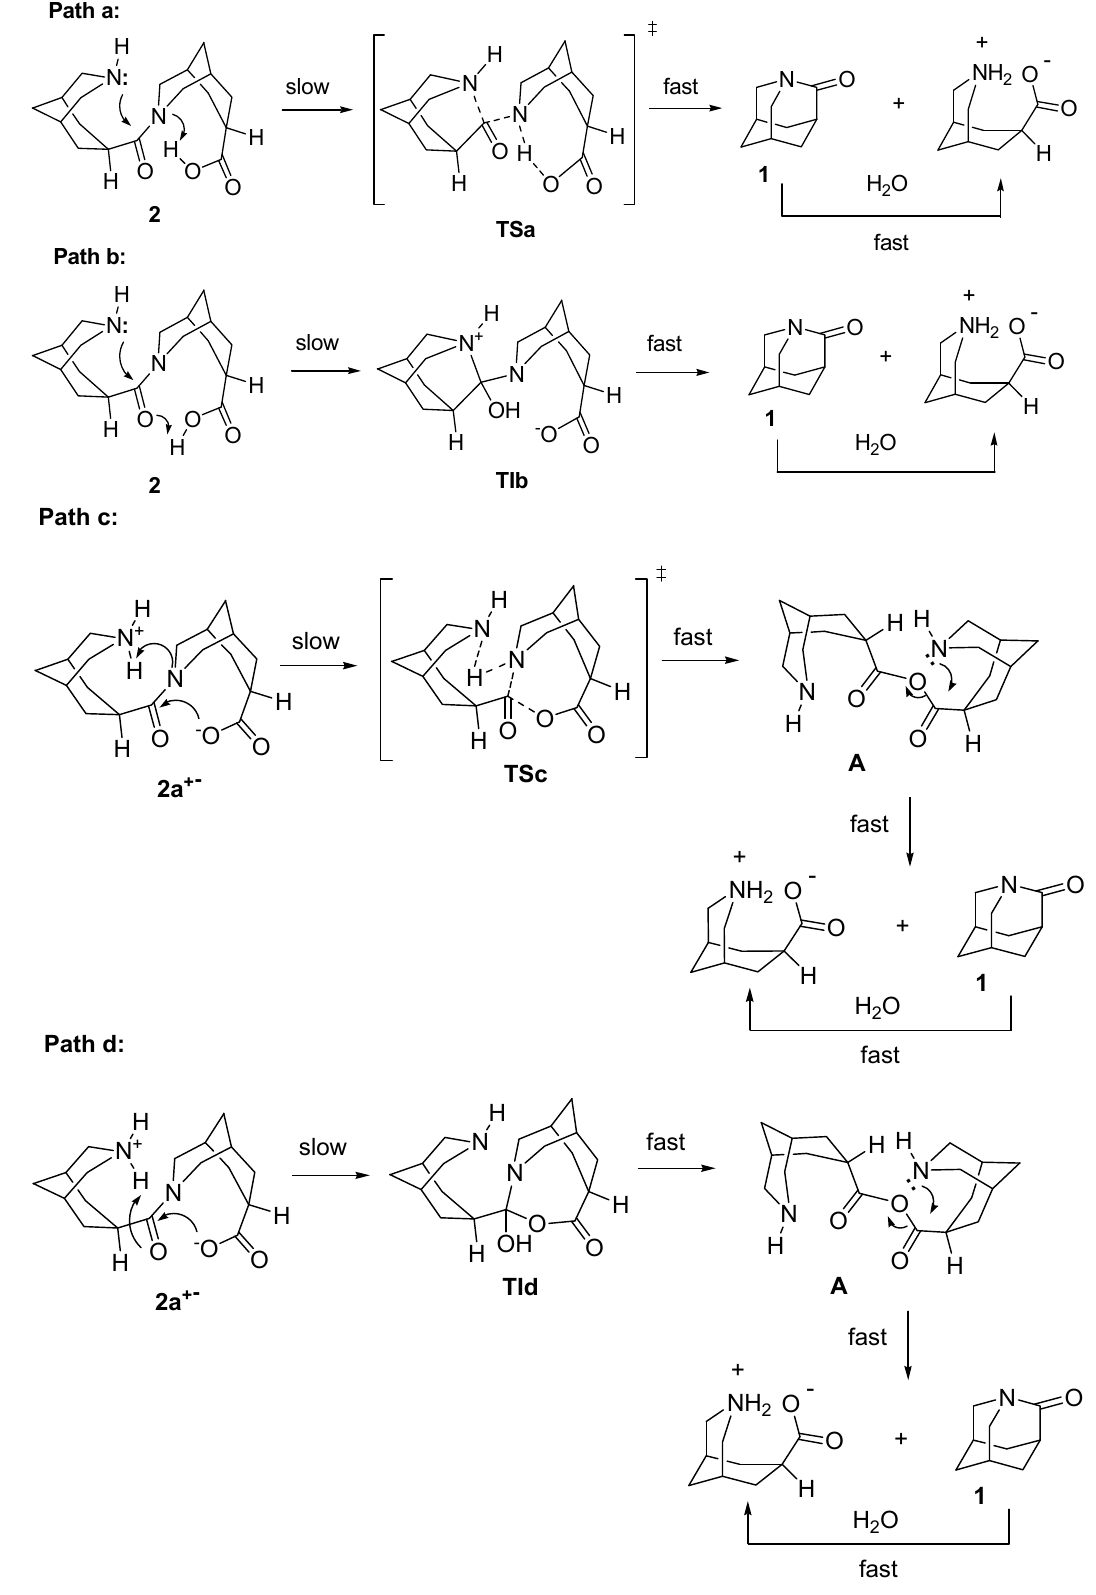
Figure 7 . Possible mechanisms of the hydrolysis of the amide 2. Figure 7. Possible mechanisms of the hydrolysis of the amide 2